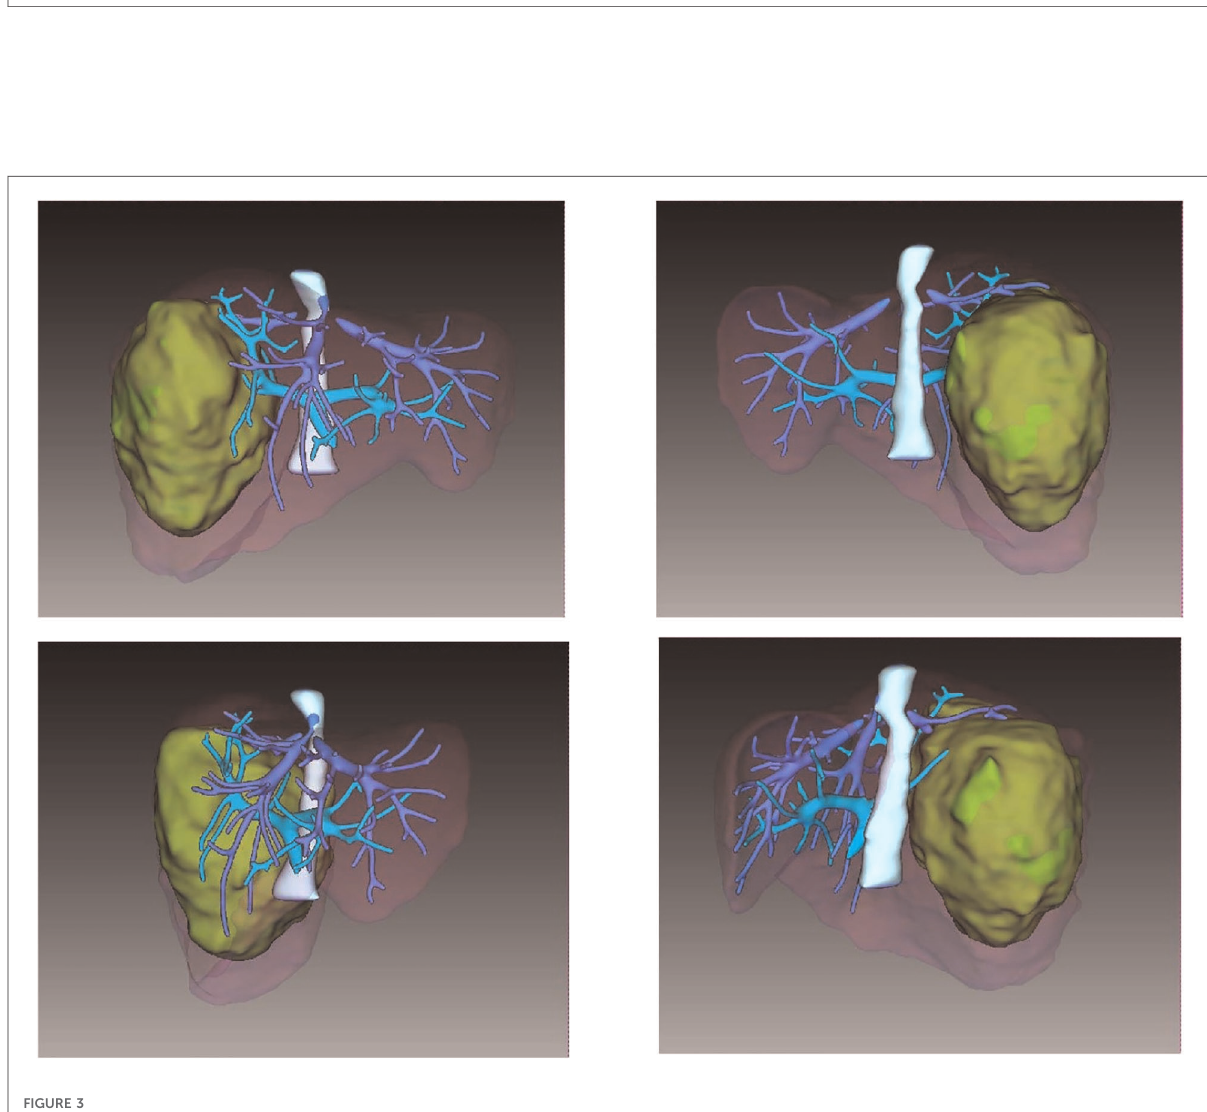
FIGURE 3 Three dimensional imaging of tumor and vessel added with